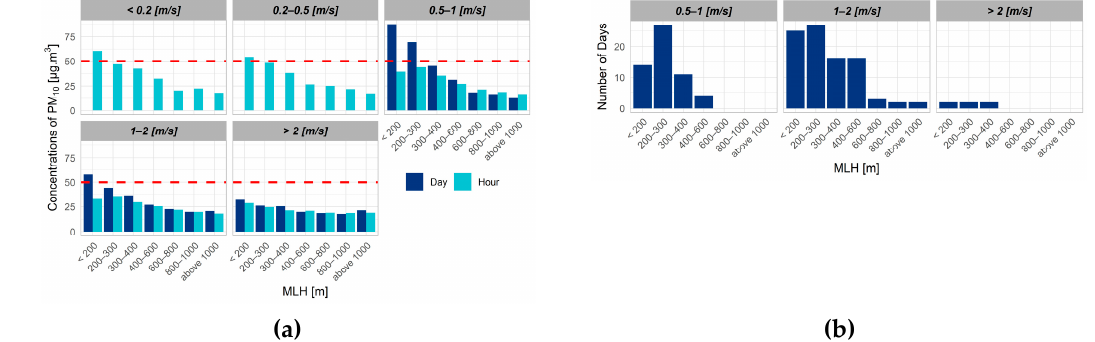
Figure 12. The Tˇrinec-Kosmos site, 2016–2019: ( a ) Average PM 10 concentrations depending on the mixing layer height and wind speed; ( b ) The count of exceedances of daily concentrations of 50 µ g · m − 3 depending on the mixing layer height and wind speed.